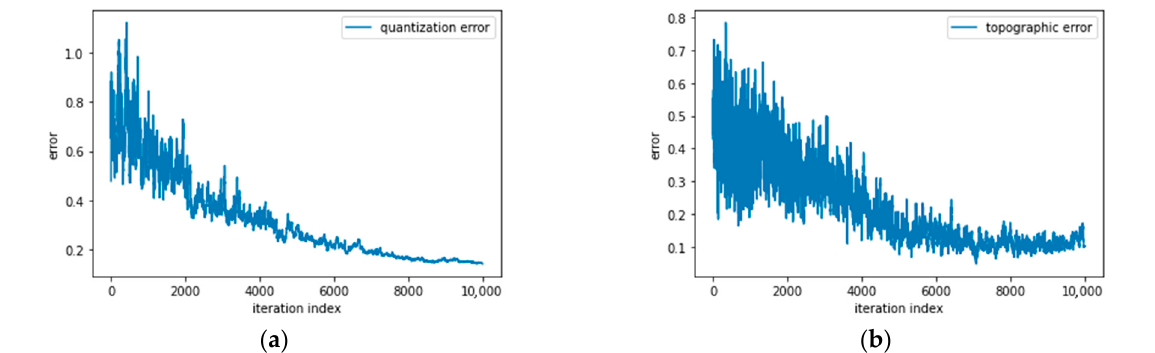
Figure 8. Parameters for network validation: ( a ) quantization error; ( b ) topographic error.